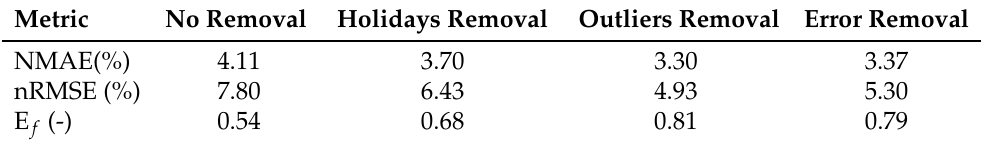
Table 3. Load forecast results in terms of accuracy.